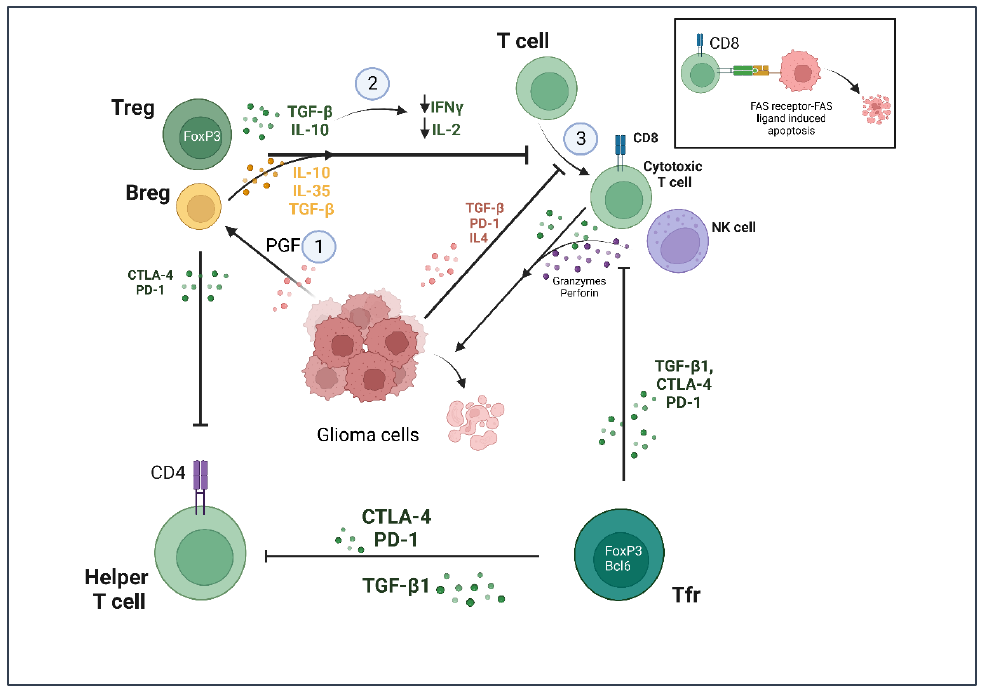
Figure 3. Summary of lymphocyte response against glioma cells. (1) Glioma cells secrete placenta growth factor (PGF), which differentiates infiltrating B cells into regulatory B (Bregs) cells. (2,3) Tregs and Bregs induce an immunosuppressive environment and inhibit development of CD8+ cytotoxic T cell and its cytotoxic effect on tumor cells. Tfr cells inhibit helper and killer T cell function by secretion of PD-1, CTLA-4 and TGF-β1 signaling, while also inhibiting NK cells. NK cells lyse glioma cells by secreting granzymes and perforin. Created with BioRender.com (accessed on 14 March 2023).